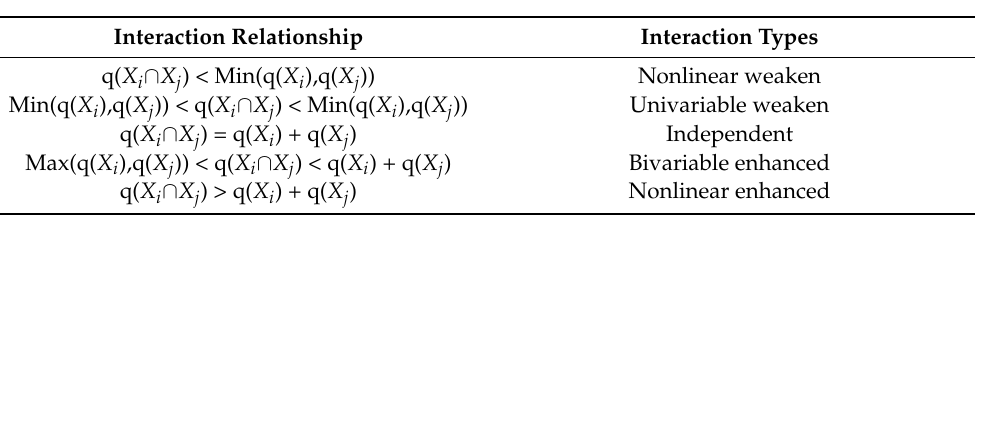
Table 4. Definition of the interaction types in the Geodetector